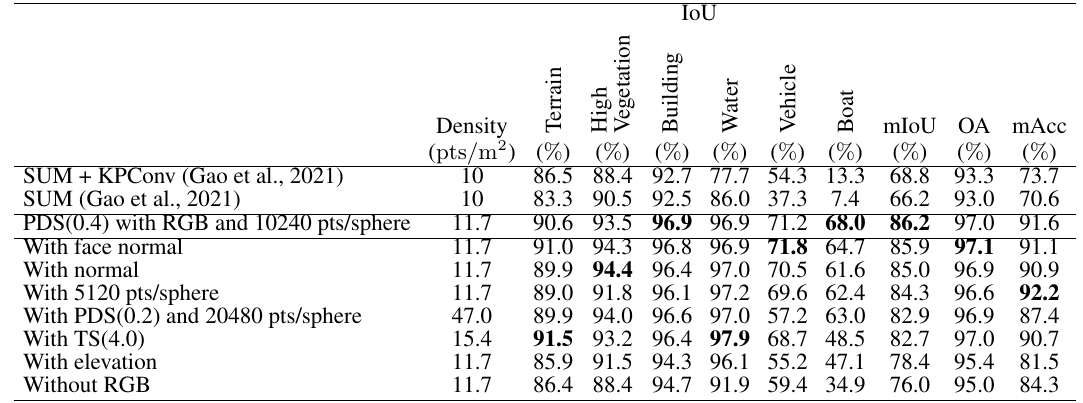
Table 1. Comparison of various sampling and feature selection. PDS( r ) = Poisson disk sampling, TS( s ) = texel sampling. the elevation seems to decrease the performance, especially